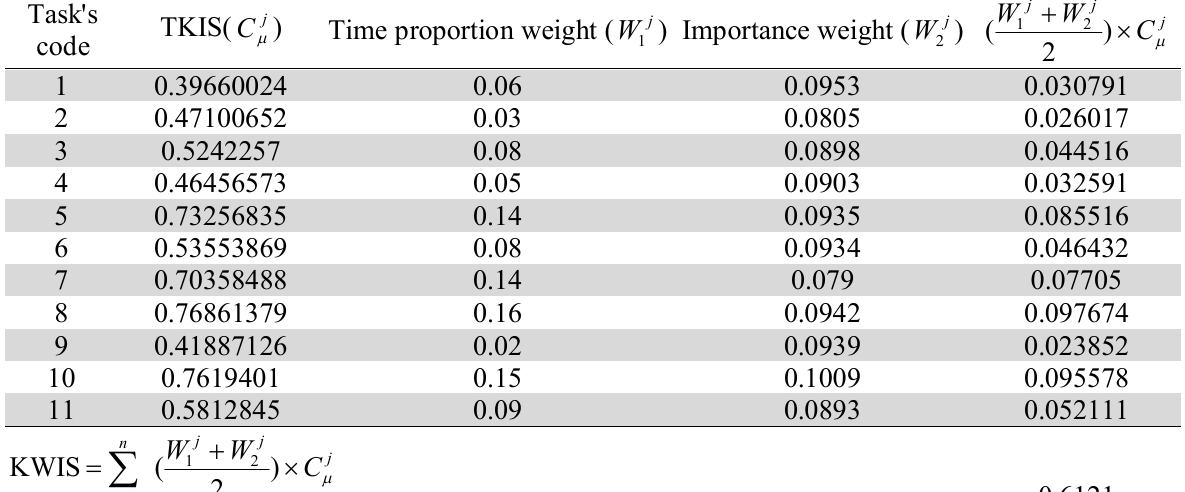
KWIS calculation for Deputy of Finance and support